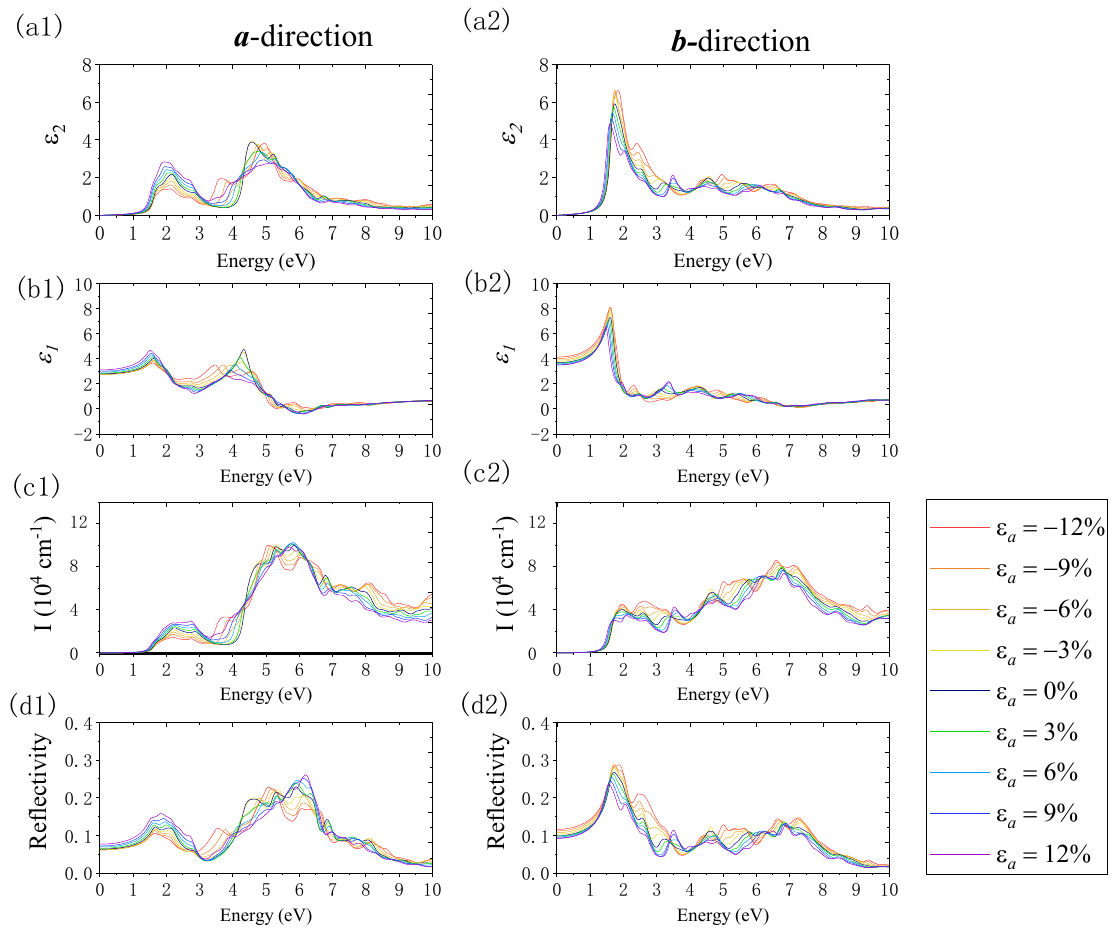
Figure 11. The variations in the imaginary part of the dielectric function ( ε 2 ), real part of the dielectric function ( ε 1 ), absorption coefficient (I), and reflection coefficient (R) when imposing the uniaxial strain along the a -direction using the PBE method. Panels ( a1 – d1 ) and ( a2 – d2 ) show the results along the a - and b -directions, respectively.